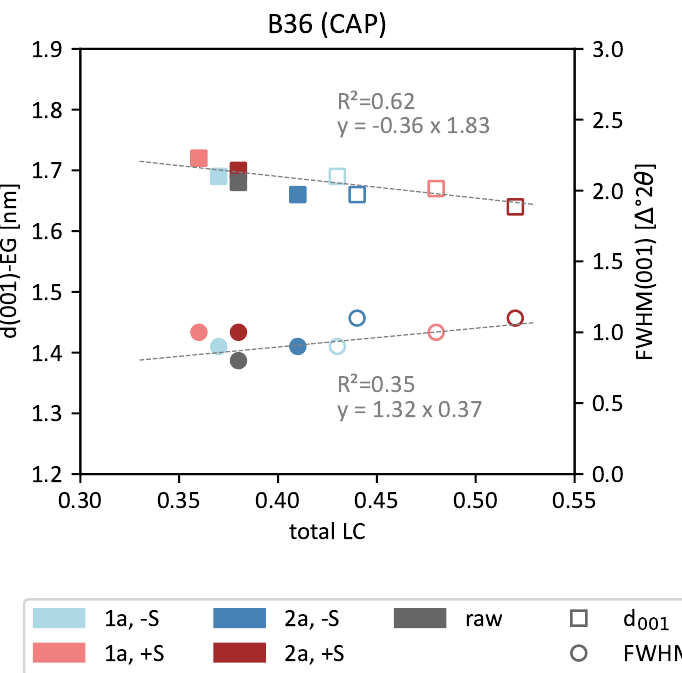
Figure 9. Plot of 001-reflection parameters against layer charge of ethylene glycol-saturated B36 samples reacted in CAP solution at 25 ◦ C (circle filled) and 90 ◦ C (circle unfilled). FWHM: full-width- at-half-maximum, LC: layer charge, –S: without substrate, +S: with